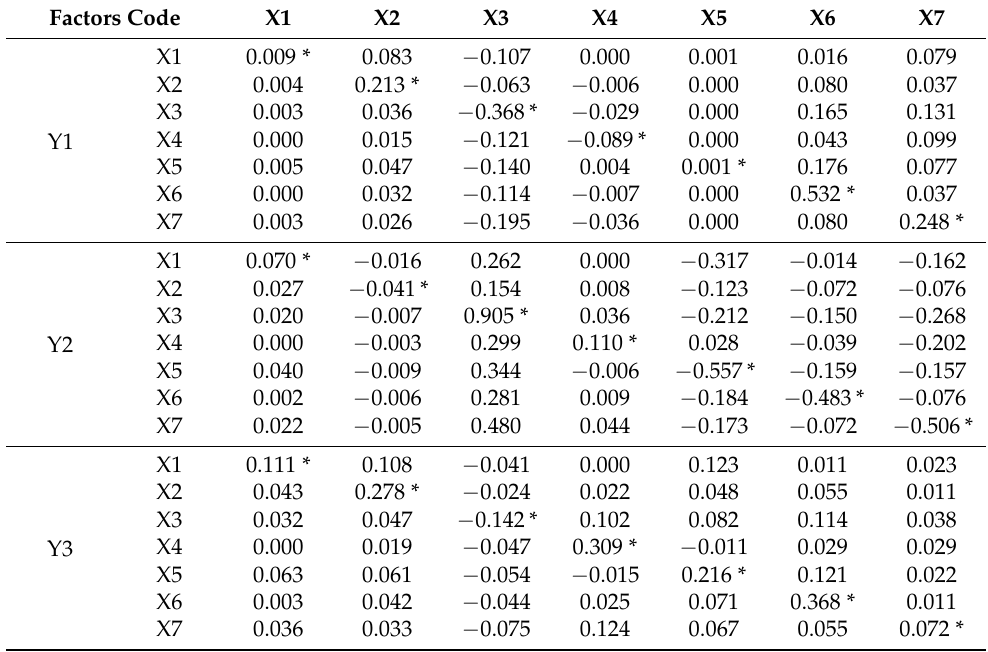
Table A3. Path coefficients between soil nutrients factors (X) and soil enzyme activity (Y) in in